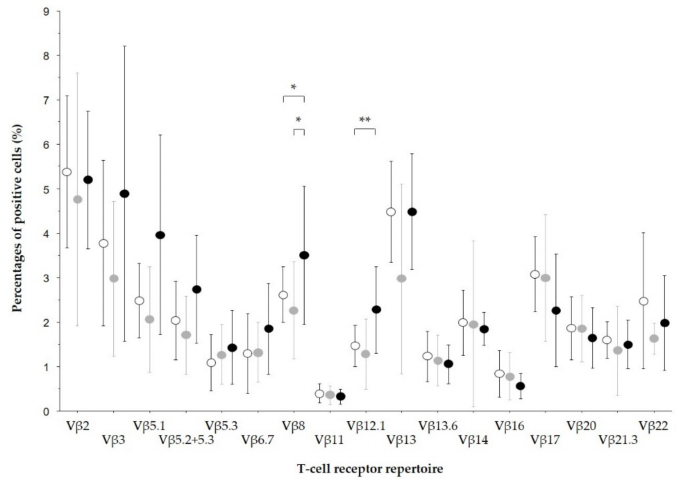
Figure 2. TCR-V β usages in SAGN with IgA-dominant deposition. Peripheral blood mononuclear cells (PBMCs) obtained from patients with SAGN, S. aureus-infected patients without glomeru- lonephritis, and healthy controls stained with fluorescence-labeled monoclonal antibodies against 17 types of TCR-V β (6 of 17 types of TCR-V β were reported [3,9–13], and the other 11 types are unpublished data); V β 5.1 (V β 5c), V β 5.2+5.3 (V β 5a), V β 5.3 (V β 5b), V β 6.7 (V β 6a), V β 8 subfamily (V β 8a) and V β 12.1 (V β 12a), V β 2, V β 3 (V β 3a), V β 11, V β 13 (V β 13a), V β 13.6, V β 14, V β 16, V β 17, V β 20, V β 21.3, and V β 22. The stained PBMCs were then analyzed using flow cytometry. The per- centages of 17 TCR-V β -positive cells among circulating CD3-positive cells are shown. Black closed circles : the mean percentages of cells in patients with SAGN. Gray closed circles : the mean percentages of cells in S. aureus-infected patients without glomerulonephritis. Open circles : the mean percentages of cells in healthy controls. Bars : the standard deviation of positive cells. The percentages of V β 8- and V β 12.1-positive cells in the SAGN patients were significantly increased compared to those in the controls, and the percentages of V β 8-positive cells in the patients with SAGN were significantly higher compared to those in patients without glomerulonephritis (* p < 0.05; ** p <